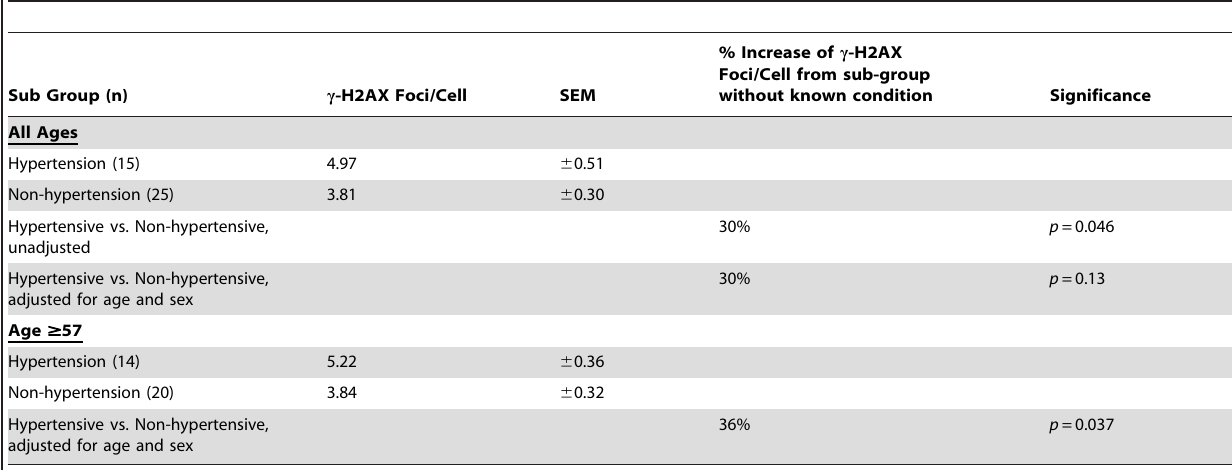
Figure 3. Box plots of c -H2AX foci/cell in mononuclear cells by age for patients with vitamin D deficiency and hypertension. ( A ) Box plot of c -H2AX foci/cell in human leukapheresis-derived mononuclear cells by age for patients with vitamin deficiency compared to those with no known vitamin D deficiency. ( B ) Box plot of c -H2AX foci/cell in human leukapheresis-derived mononuclear cells by age for hypertensive patients vs. non-hypertensive patients. ( C ) Box plot of c -H2AX foci/cell in human leukapheresis-derived mononuclear cells by age for hypertensive patients vs. non-hypertensive patients, age $ 57 y/o. The top of each box in the box plots indicates the 75 th percentile, the bottom of each box indicates the 25 th percentile and the bar inside the box is the median. The whiskers extend out to the most extreme data point that is at most 1.5 times the interquartile range above the third quartile or below the first quartile. The circle in Figure 3 (A) indicates a result from a patient above this range. doi:10.1371/journal.pone.0045728.g003 Table 2. c -H2AX foci/cell in human leukapheresis-derived mononuclear cells for hypertensive and non-hypertensive patients.